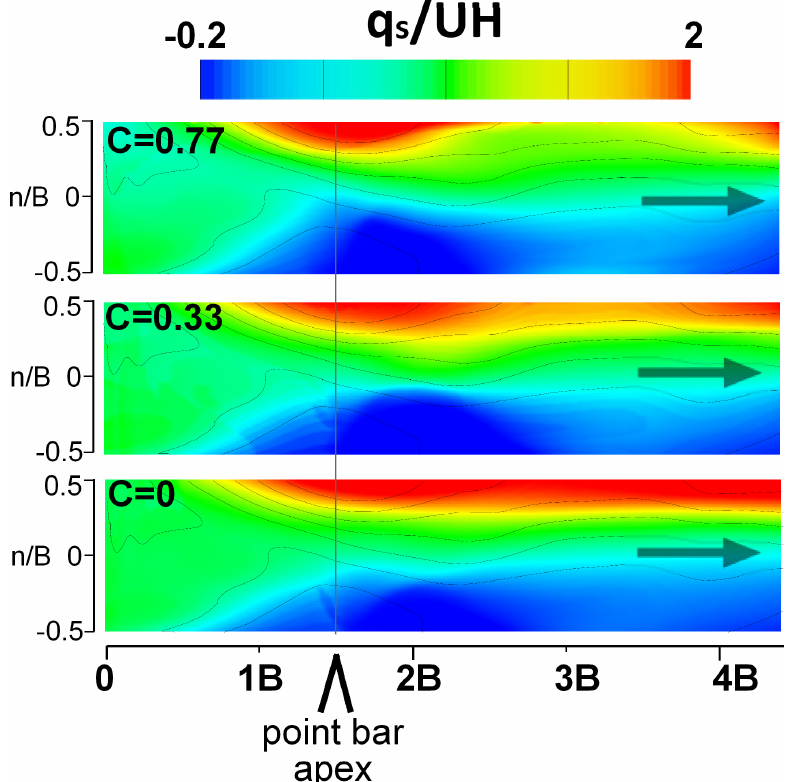
Figure 4. Streamwise unit discharge q s / UH for channel curvature C = 0.77, 0.33, and 0